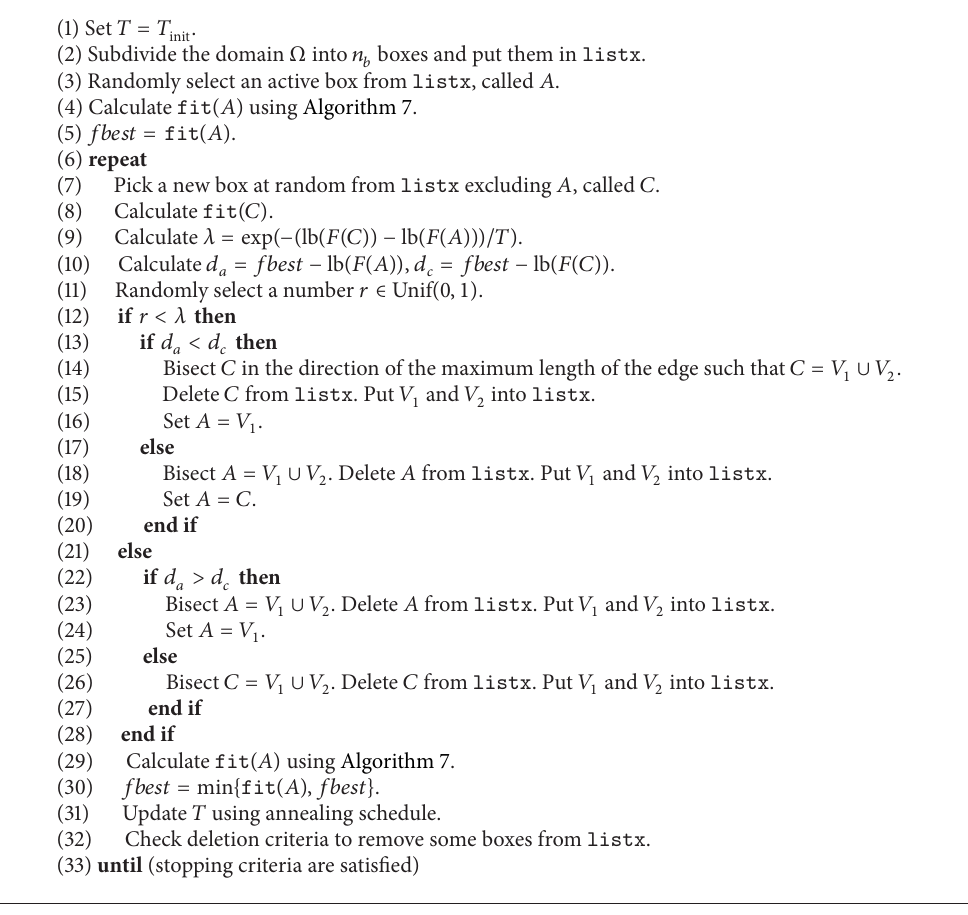
Algorithm 7: Calculate 𝑦 = fit (𝑋)